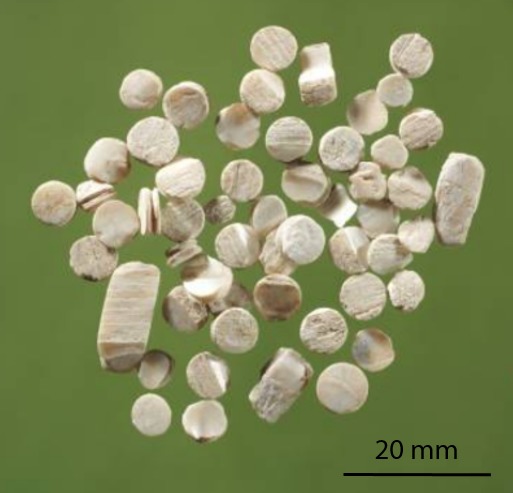
The double-buttons from Havnø.